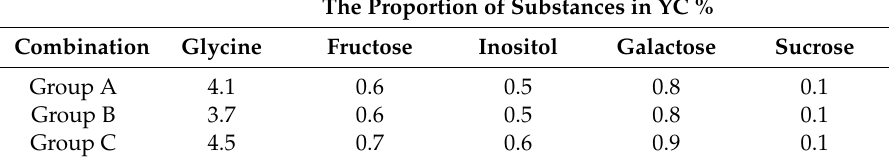
Table 6. Combination schemes of the active component for the preparation of feed additives. According to the regression model, the production performance was obtained as the daily body weight gain with supplementation of yeast culture fermented for 24 h. The corresponding value was obtained for each active component. On this basis, the proportion of each component was adjusted (each component + 10%) to configure the content of each component for groups A–C. The Proportion of Substances in YC % Combination Glycine Inositol